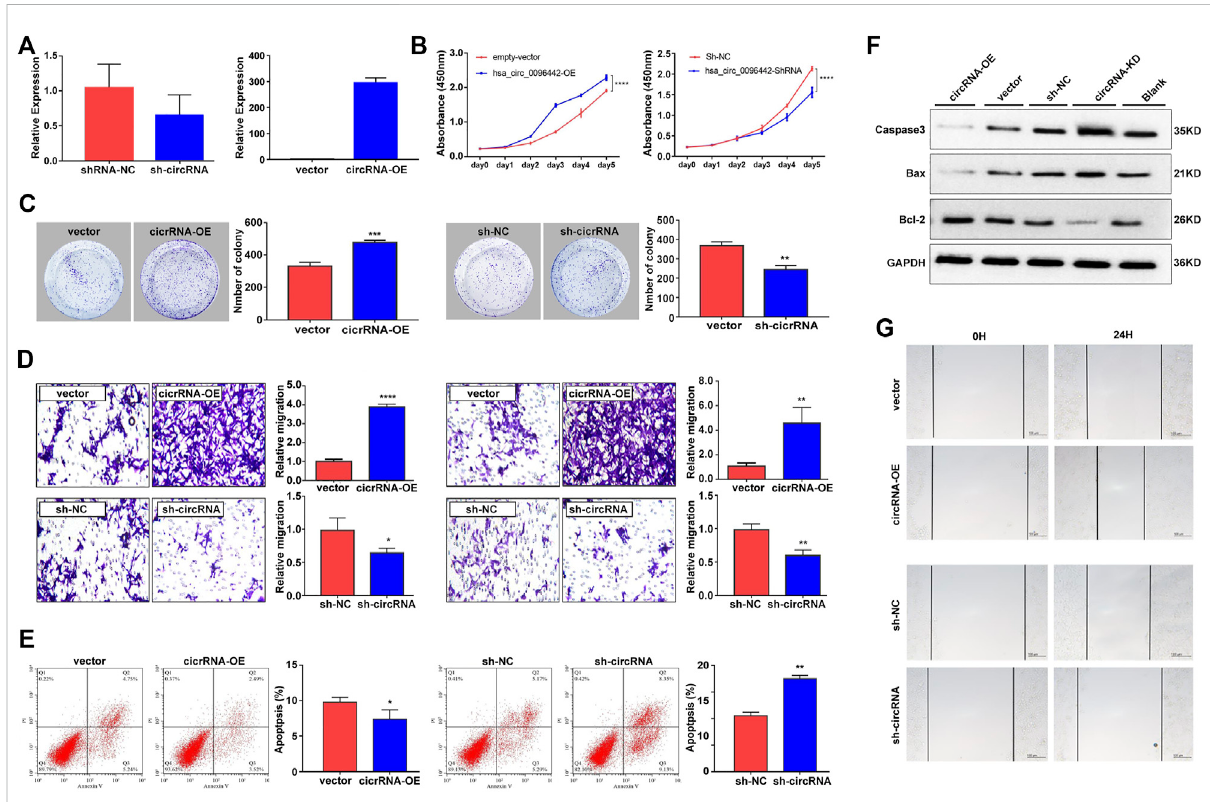
FIGURE 7 Circ_0096442 promotes proliferation and migration/invasion of A549 cells in bone microenvironment. (A) RT-qPCR detection showing the expression of circ_0096442 in overexpression and knockdown stable A549 cells. (B) Cell proliferation was detected by CCK8 assays. (C) Cell proliferation was detected by colony formation assays. (D) Transwell assays were applied to discover the migration/invasion ability of A549 cells in bone microenvironment. (E) Apoptosis assay by fl ow cytometric analysis. (F) Western blot analysis for the detection of pro-apoptotic and anti- apoptotic proteins. (G) Impact of circ_0096442 on A549 cellular migration assessed through wound healing